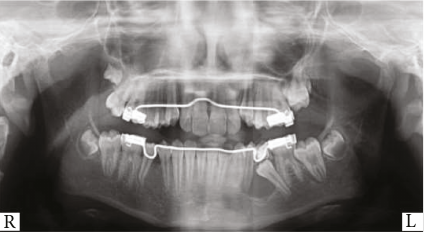
Figure 1: Orthopantomogram (OPG) showing a radiolucent lesion at the mandibular left side (second premolar